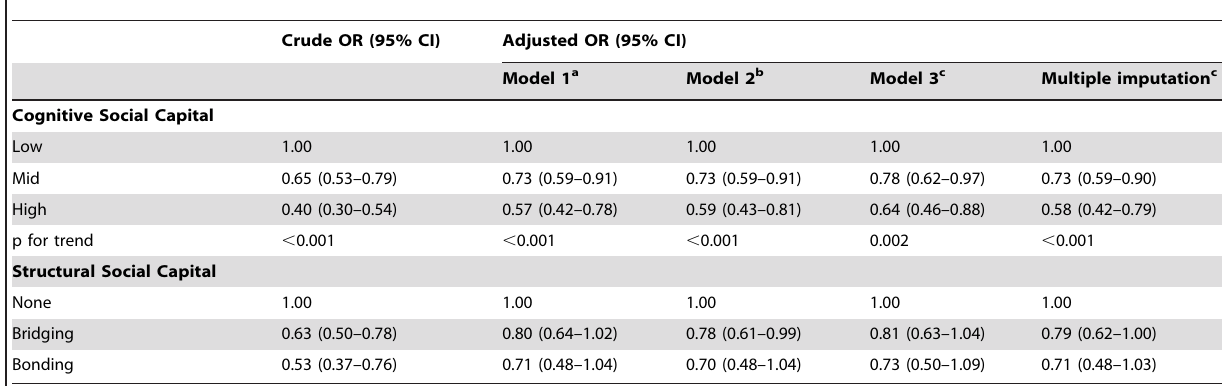
Table 4. Odds ratios for physical inactivity associated with social capital within